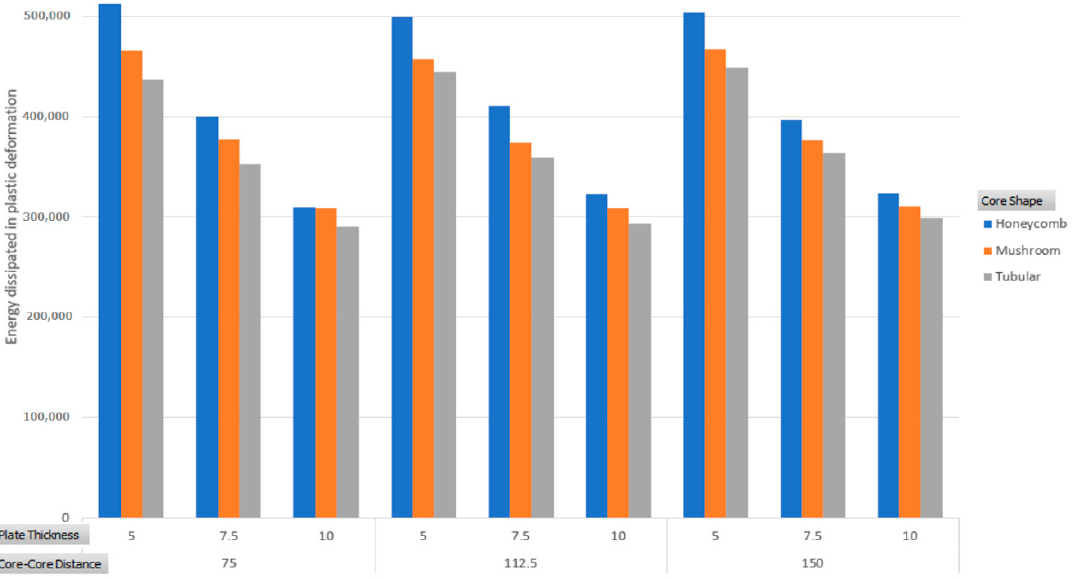
Figure 20. Energy dissipated by plastic deformation categorized by core shape, plate thickness, and core–core spacing. core–core